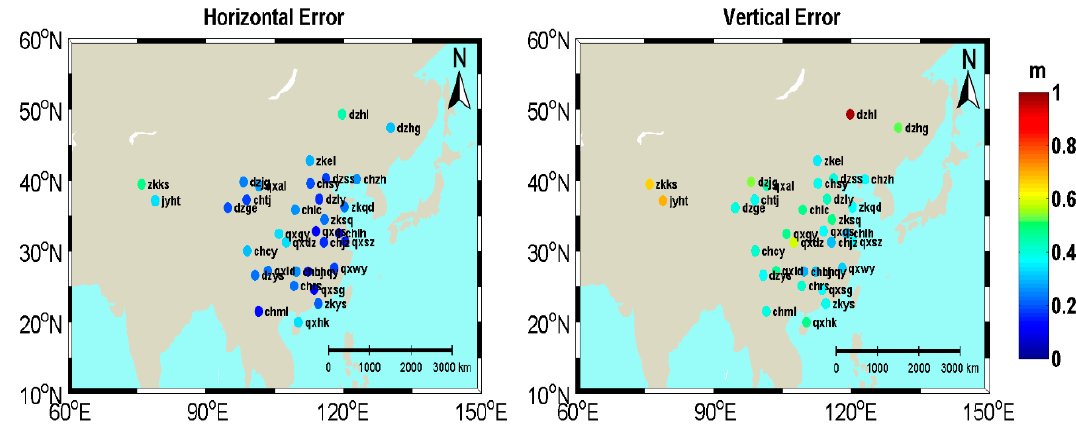
Figure 9. BDS real-time dual-frequency PPP positioning accuracy at the 95% confidence level.